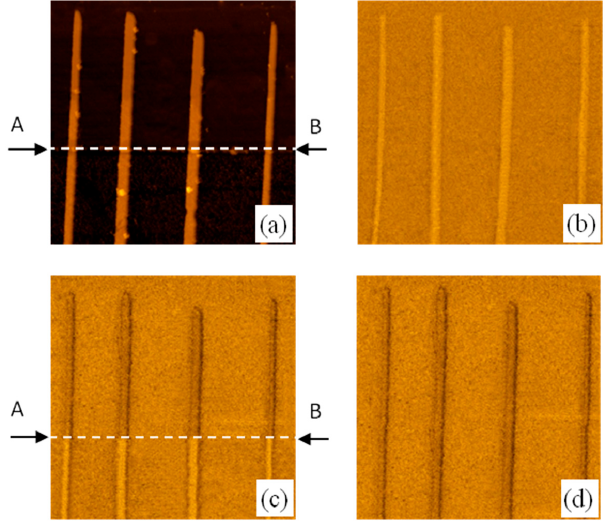
Figure 5. The sequential stages of remagnetization for Co/Pt NWs partly covered by Co capping layer. ( a ) The AFM image of the sample with Co/Pt NWs. The area below line A-B is covered by Co (1.3 nm) capping layer. The border of Co capping layer is shown by arrows and dashed line; ( b ) The MFM image of up-magnetized sample; ( c ) The MFM image of partly remagnetized NWs after applying of 150 Oe reversed magnetic field; ( d ) The MFM image of down-magnetized NWs in the field of 200 Oe. The frame sizes are 1.5 μ m × 1.5 μ m. The MFM contrast is normalized to the maximum.